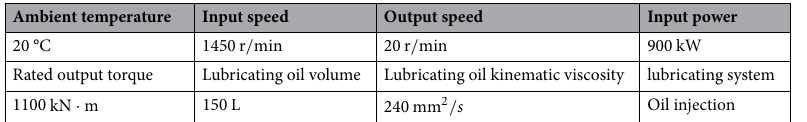
Table 4. Gearbox working